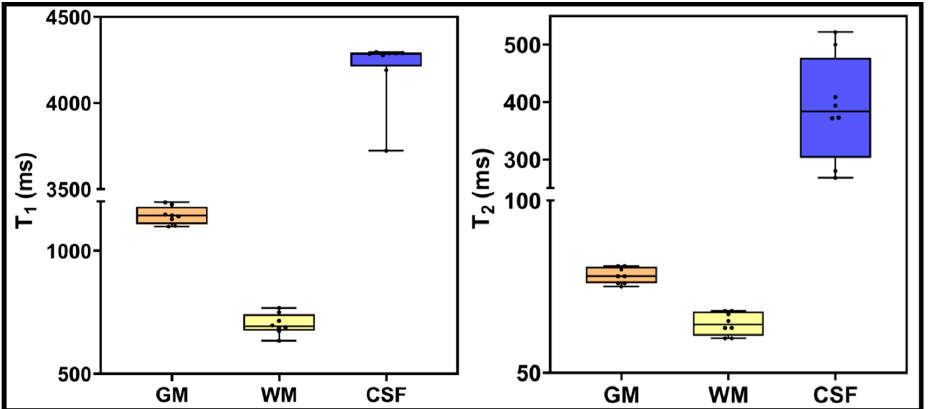
Figure 4. T1 and T2 values for normal-appearing GM, WM, and CSF using T1 and T2 maps generated from MAGiC methods. Boxes represent the interquartile range; whiskers represent the range of all values; the horizontal line within the box is the median value.